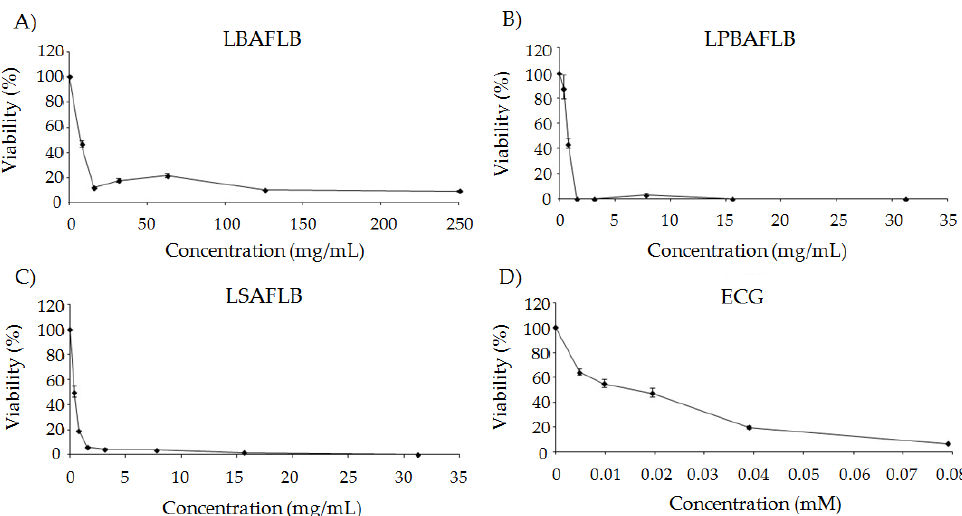
Figure 4. Effect of lyophilised blond alcohol-free lager beer (LBAFLB), lyophilised pale-blond alcohol-free lager beer (LPBAFLB), lyophilised stout alcohol-free lager beer (LSAFLB) and epicatechin gallate (ECG) on cell viability. Viability in promyelocytic human leukaemia cells (HL-60) treated with different concentrations of LBAFLB ( A ), LPBAFLB ( B ), LSAFLB ( C ) and ECG ( D ) for 72 h. Each point represents the growing percentage compared to its control. Values are mean +/ − SE from three independent experiments.